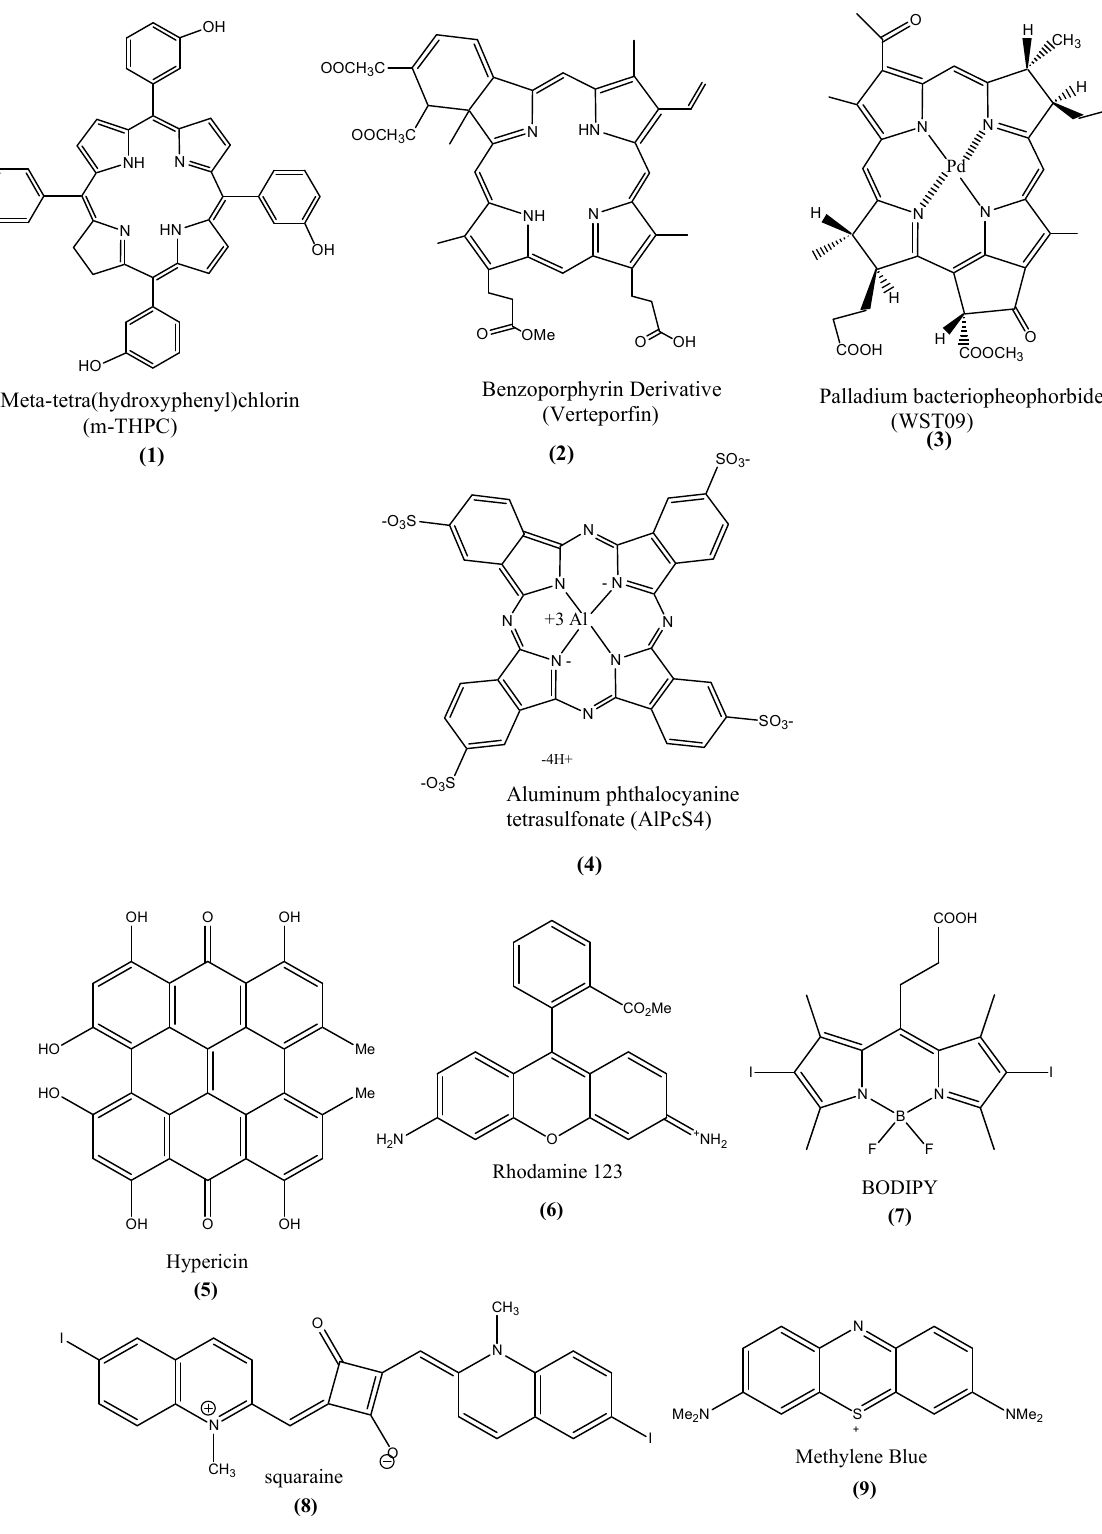
Figure 1. Examples of porphyrin ( 1 – 4 ) and non-porphyrin ( 5 – 9 )